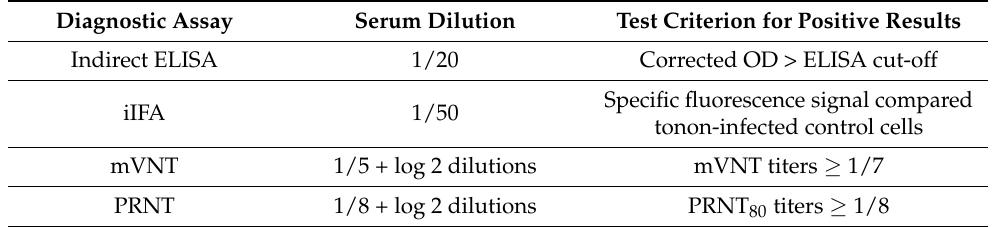
Table 2. Serological assays.